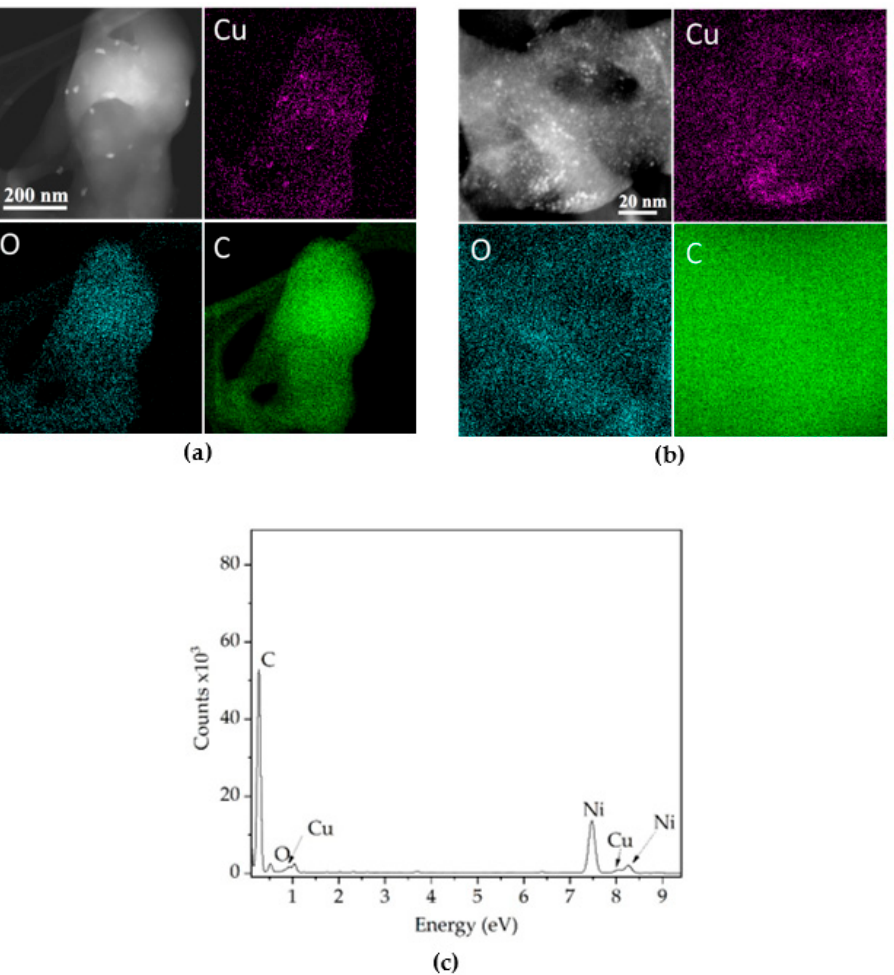
Figure 4. Elemental mapping images according to the copper oxide particle size around ( a ) 20 nm and ( b ) 3 nm ( c ) EDS spectra. and ( b ) 3 nm ( c ) EDS